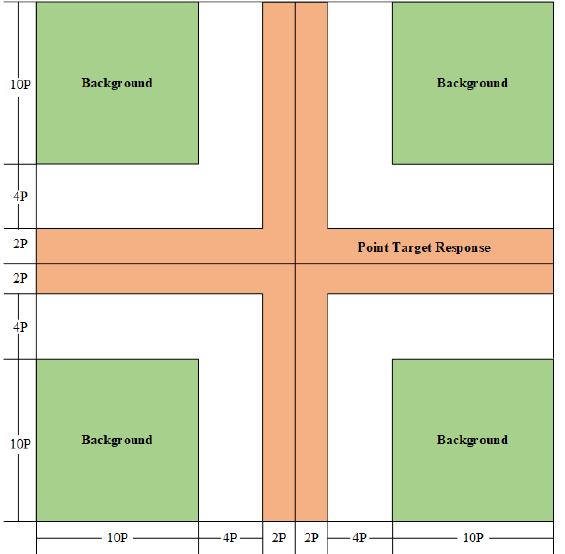
Figure 8. Schematic of point target response integration window.